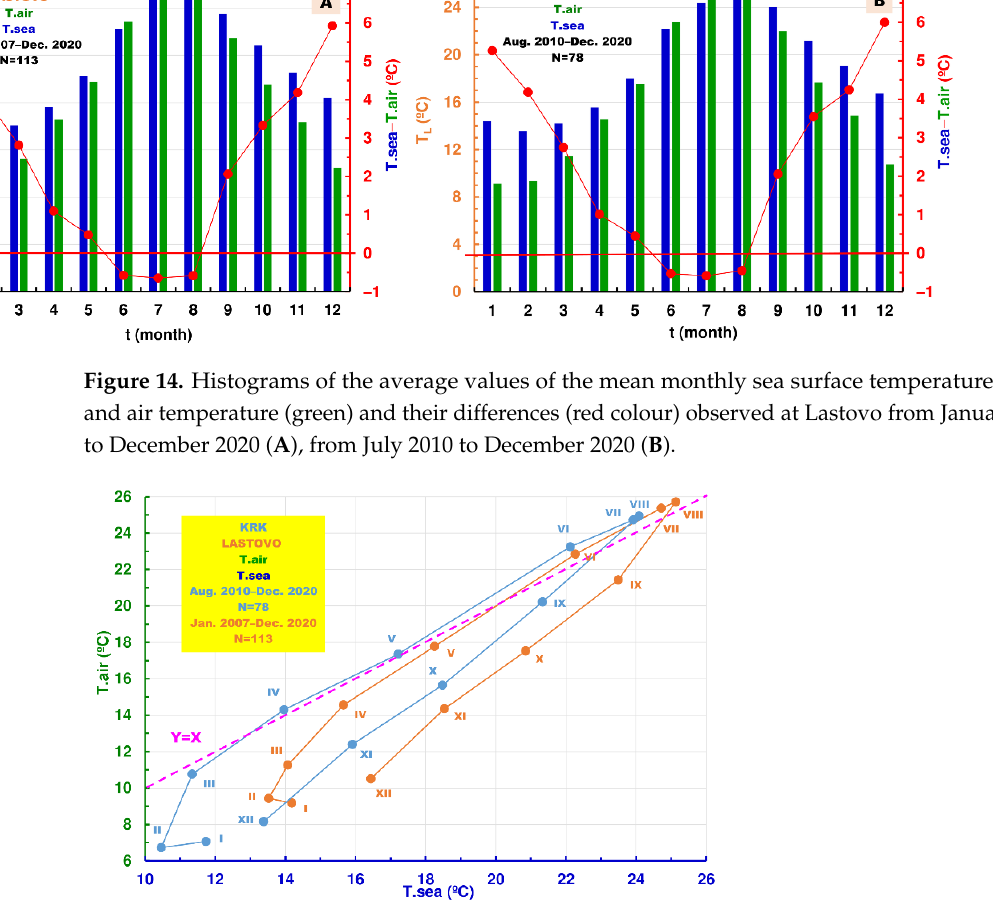
Figure 15. Relationships between the average values of the mean monthly air (ordinate axis) and sea surface (abscissa axis) temperatures at Krk (blue) and Lastovo (brown) with marks of each month (I – XII).